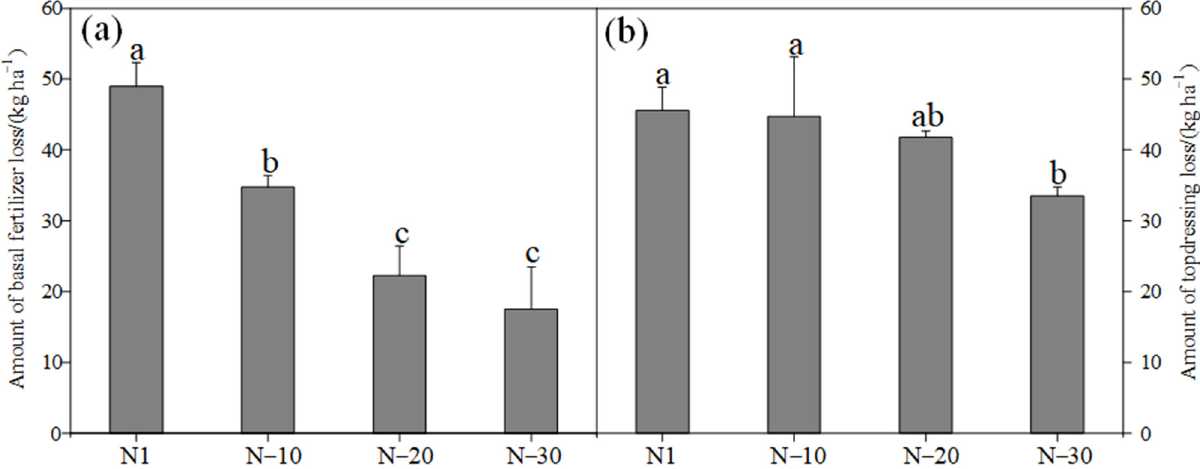
Figure 5. Nitrogen loss from basal fertilizer ( a ) and topdressing fertilizer ( b ). Note: different letters indicate significant differences ( p < 0.05). N0, N1, N − 10, N − 20 and N − 30 represent the five fertilization treatments.